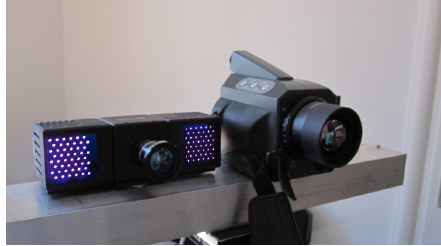
Figure 11: Visualization of thermal information mapped onto the respective 3D point cloud for two different scenes: 2D image pro- jections (top) and colored 3D point clouds (center and